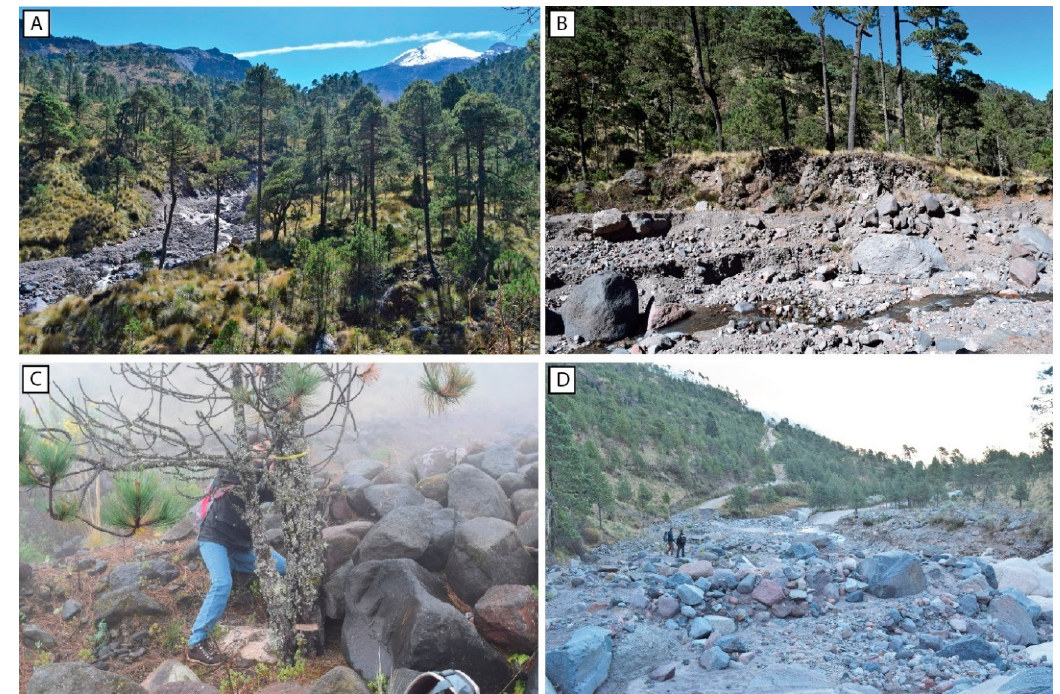
Figure 2. Geomorphic characteristics of Jamapa Gorge. ( A ) Active channel with recent lahar deposits. ( B ) Lahar terraces formed by historical events. ( C ) Trees of Pinus hartwegii buried and impacted by blocks and sediment. ( D ) Recent lahar deposits burying the road at 3546 m a.s.l.